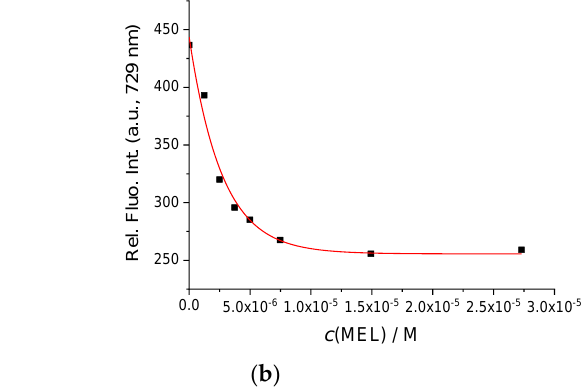
Figure 2. ( a ) Fluorescent emission spectra of AuNC@BSA ( c (BSA) = 0.715 μ M or c (Au 25 , AuNC@BSA = 0.379 µM in a cuvette) upon titration with MEL in water ( λ exc = 540 nm, S exc = 6, S em = 6) at 298 K; ( b ) emission dependence of AuNC@BSA on c (MEL) at λ max = 729 nm. R 2 = 0.99. However, since MEL has no absorbance at the excitation wavelength of AuNC@BSA, no inner filter effect corrections were needed, and thus the biding constant could be more accurate (Figure 2b). It should be noted that the fluorescence of AuNC@BSA is only about 50% quenched when reaching the full saturation plateau, thus complexes are still measurably emissive. The binding constants of BSA with DSS were previously determined with the equilibrium dialysis method [38]. According to the authors, it appears that the interaction of BSA with DSS is a two-site binding process, with binding constants K ass1 = 6.00 × 10 5 M − 1 and K ass2 = 1.59 × 10 3 M − 1 at 293.15 K, pH = 0.4, and I = 0.1 M. Figure 3a,b show the fluorometric titration of AuNC@BSA with DSS in water at 298 K with λ exc = 365 nm and λ exc = 540 nm, also supporting the formation of two different complexes—however, small emission changes prevented accurate calculation of binding constants.